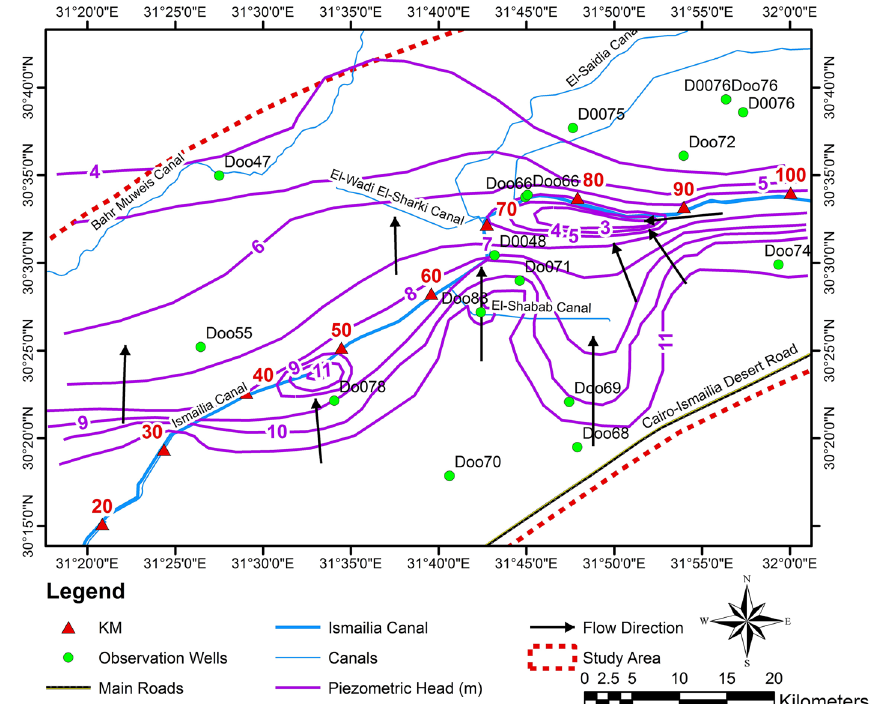
Fig. 3 Groundwater flow direction map in the study area